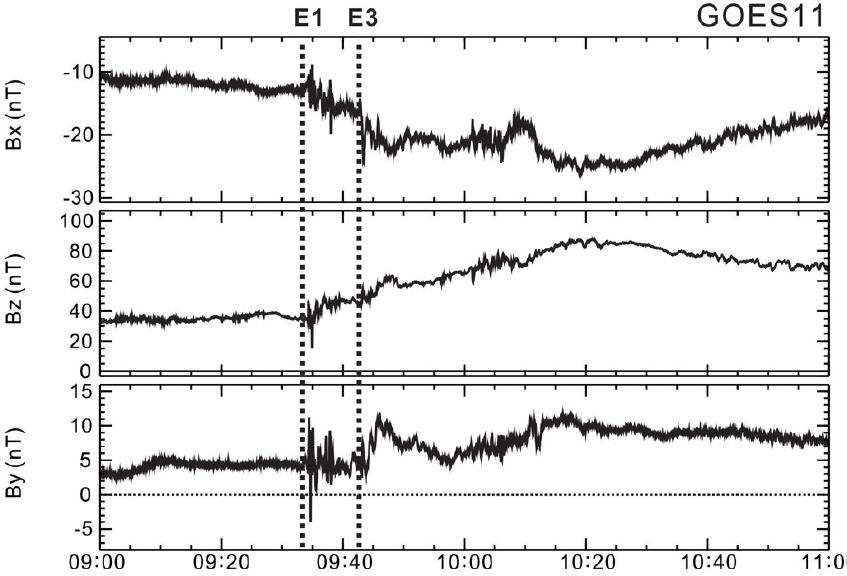
Fig. 5. Three components of the magnetic field in GSM coordinate observed by GOES 11 satellite between 09:00UT and 11:00UT on 5 December